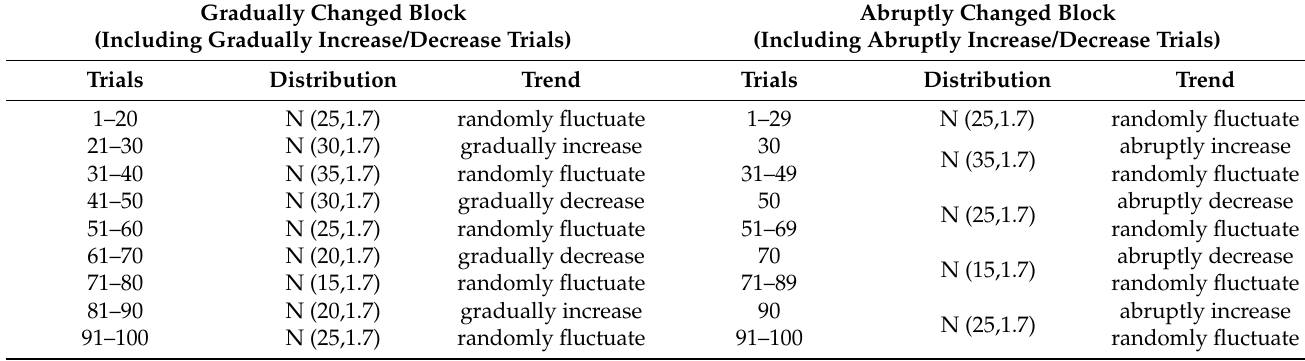
Table 1. The distribution of target values in two formal